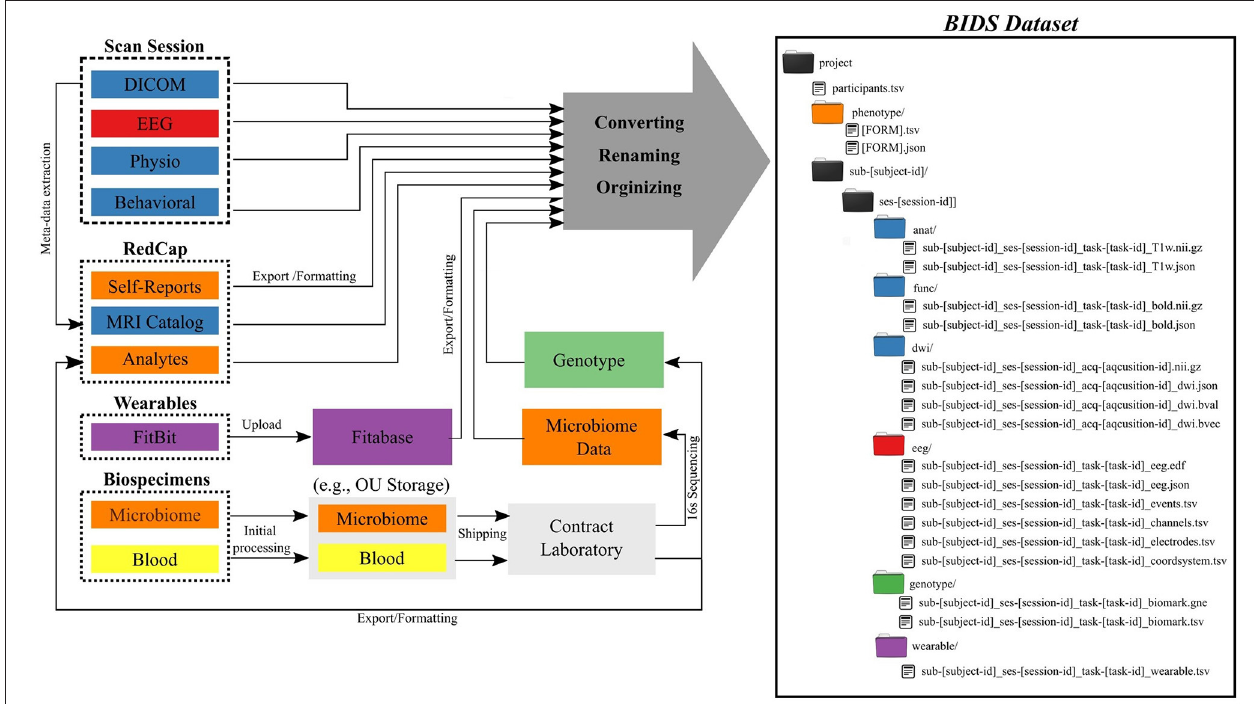
FIGURE 1 | Common Data Elements and Scalable Data Management Infrastructure. Data generated and represented with different colors (left) are converted into the BIDS file structure (right), where colors of directories correspond to data types on left.